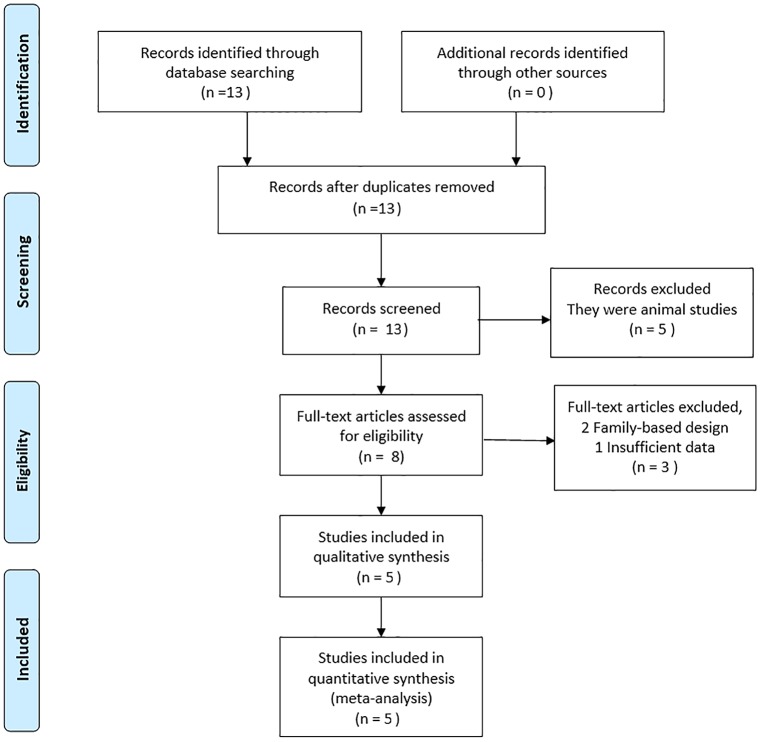
Flow chart of the study selection process.Literature search flow.